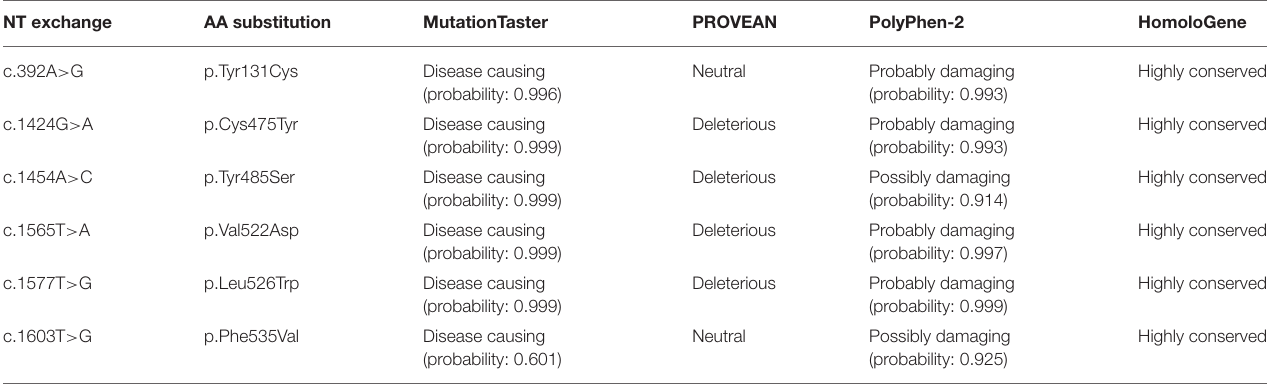
TABLE 3 | In silico analysis of novel amino acid changes.